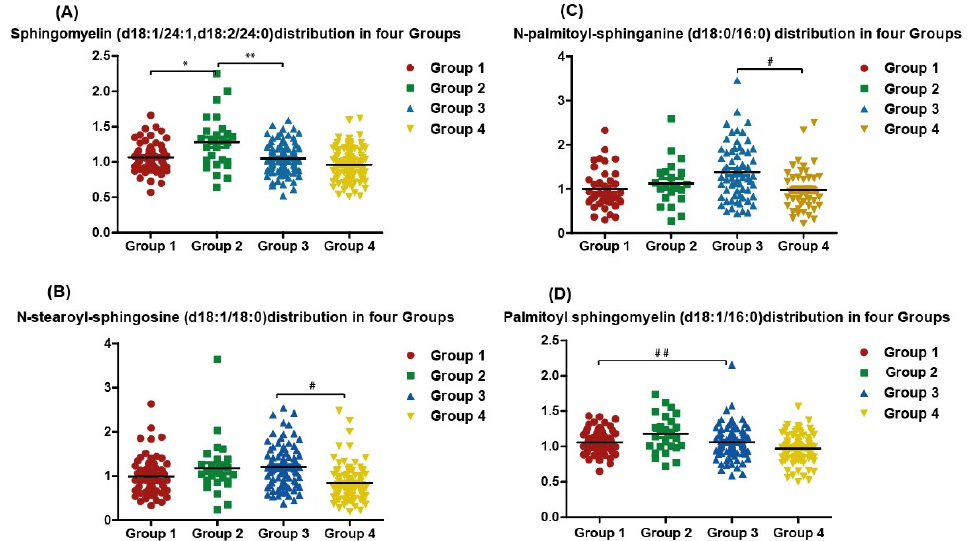
Figure 4. Metabolites quantity distribution among four groups of participants. ( A ) sphingomyelin